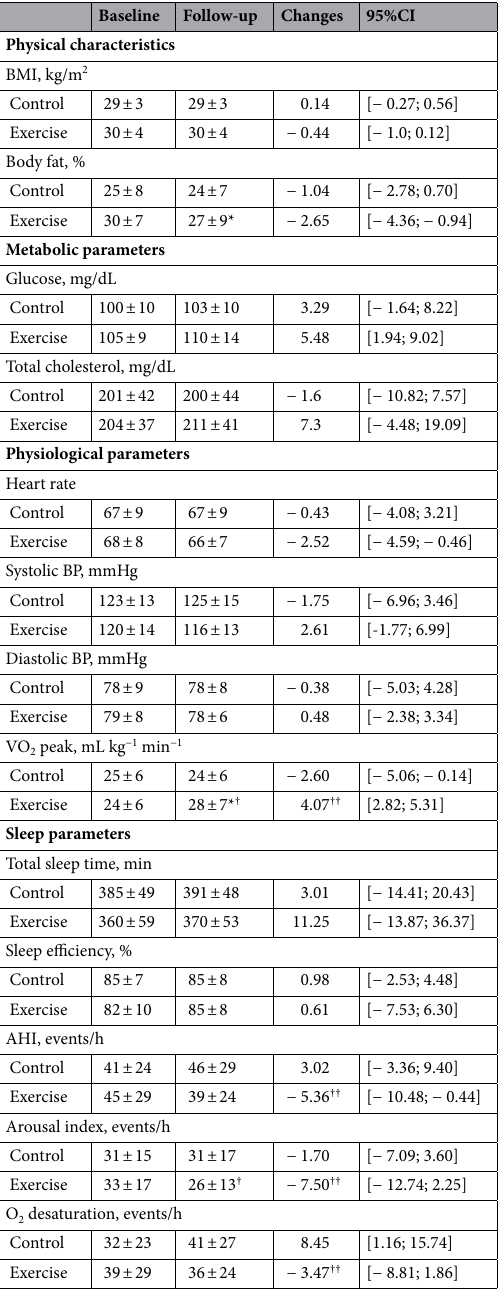
Table 2. Effects of exercise training on physical characteristics, physical capacity, and sleep parameters in individuals with obstructive sleep apnea. Data are means ± SD and means of delta changes [95% CI]. BMI body mass index, BP blood pressure; VO 2 oxygen uptake; AHI apnea–hypopnea index. P value indicates comparisons between groups (2-way ANOVA). *Within group comparison, P < 0.05. † Between group comparisons in post intervention, P < 0.05 (detected by post hoc analysis). † † Change between groups